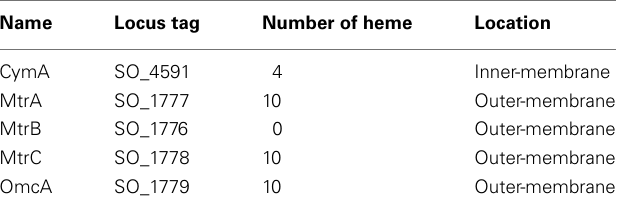
Table 1 | Identified protein components of Mtr